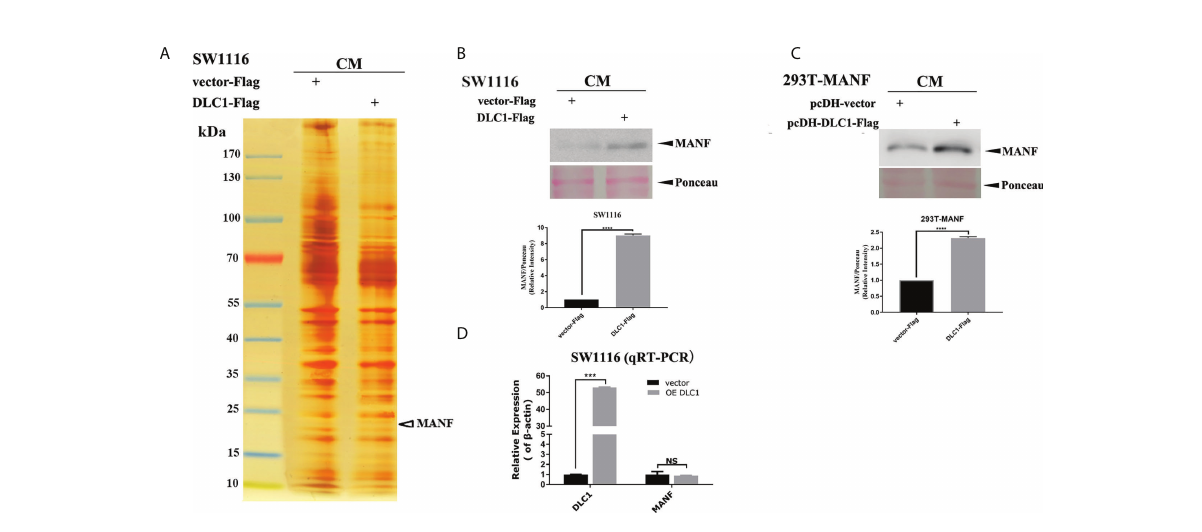
FIGURE 2 DLC1 promoted the MANF secretion. (A) MANF was identi fi ed by mass spectrometry from the SW1116 cells cultured by overexpressed DLC1 CM. (B, C) Western blot showed that MANF protein expression increased in CM of stable DLC1-expressed SW1116 and HEK-293T compared with the vector group. The bottom panel shows the relative intensity of MANF expression compared with ponceau for the upper panel Western blot result. (D) MANF mRNA level was not altered by DLC1 overexpression in SW1116 as determined by qRT-PCR. *** p <0.001, **** p <0.0001, compared with vector group. NS, no signi fi cant difference compared with the vector